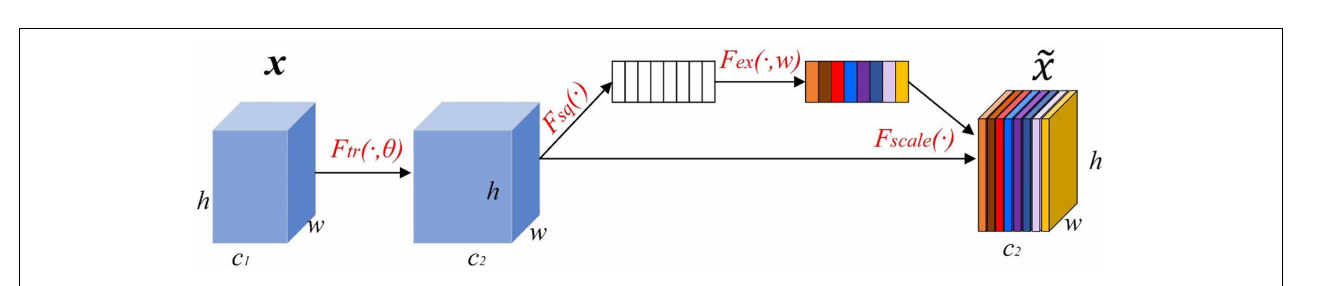
FIGURE 1 | The structure of the spatial attention mechanism.